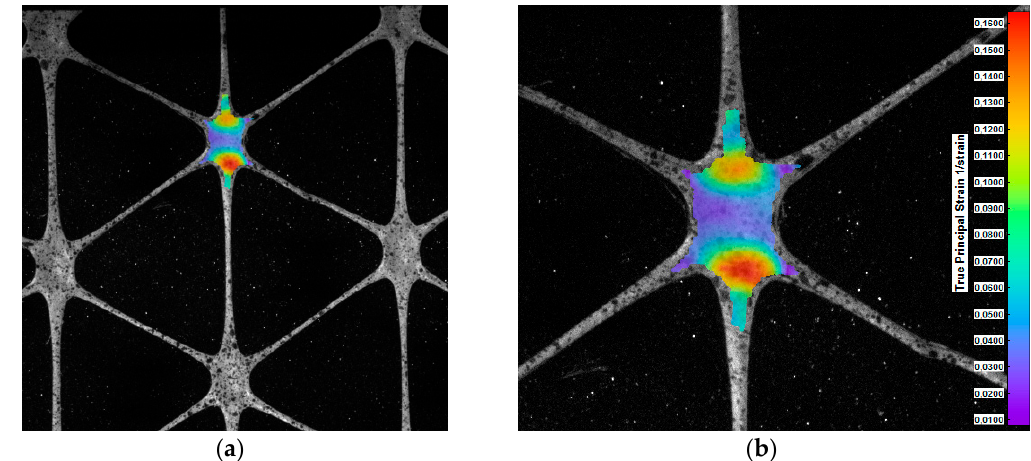
Figure 23. Map of the distribution of the principal strains 1 on the surface of the polypropylene sample: